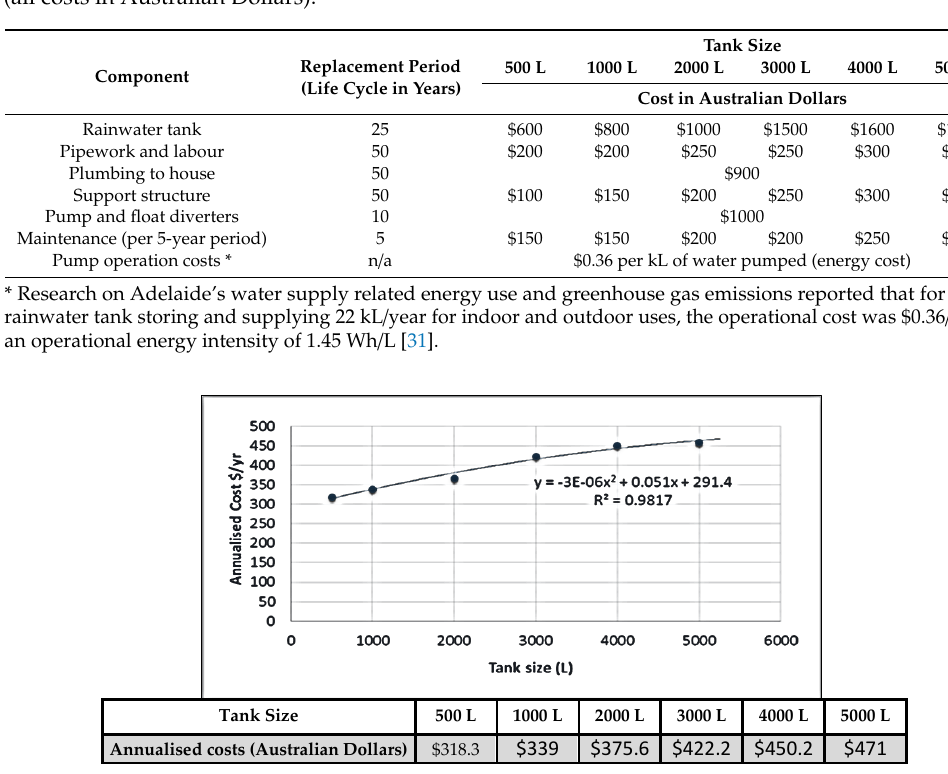
Figure 4. Annualised cost as a function of tank size.